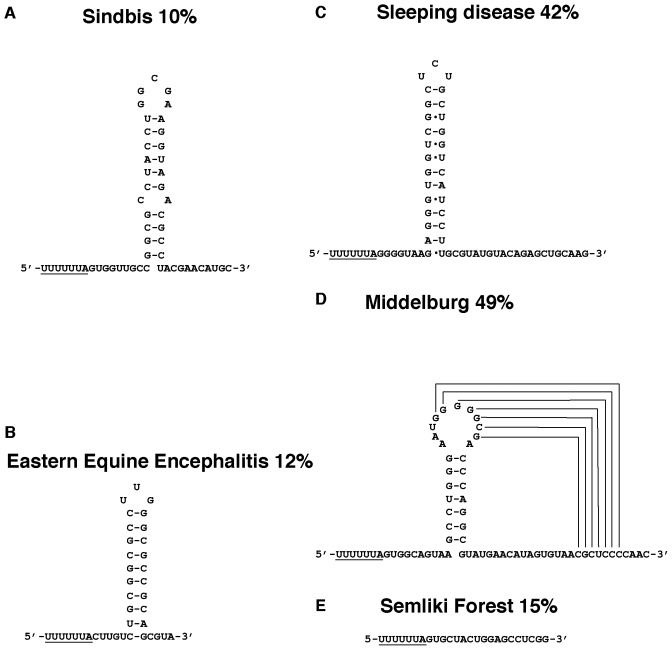
Alphavirus ribosomal frameshift stimulators are diverse. A single stem loop is the frameshifting stimulator for (A) Sindbis virus, (B) eastern equine encephalitis virus, (C) sleeping disease virus, and (D) Middelburg virus. Experimental support has been obtained for the second stem of the pseudoknot shown. (E) The stimulator for Semliki Forest virus frameshifting does not appear to involve intra-mRNA pairing, and is a candidate for exerting its effect via pairing with rRNA in the mRNA entrance channel. A similarly acting 3′ sequence may be acting as well as the pseudoknot, to stimulate the efficiency of frameshifting in Middelburg virus genome decoding to the high level of 49%. Reproduced from Chung B.Y.W., Firth A.E., Atkins J.F. (2010) Frameshifting in Alphaviruses: A Diversity of 3′ Stimulatory Structures, Journal of Molecular Biology, 397, 448–456 with permission from Elsevier.